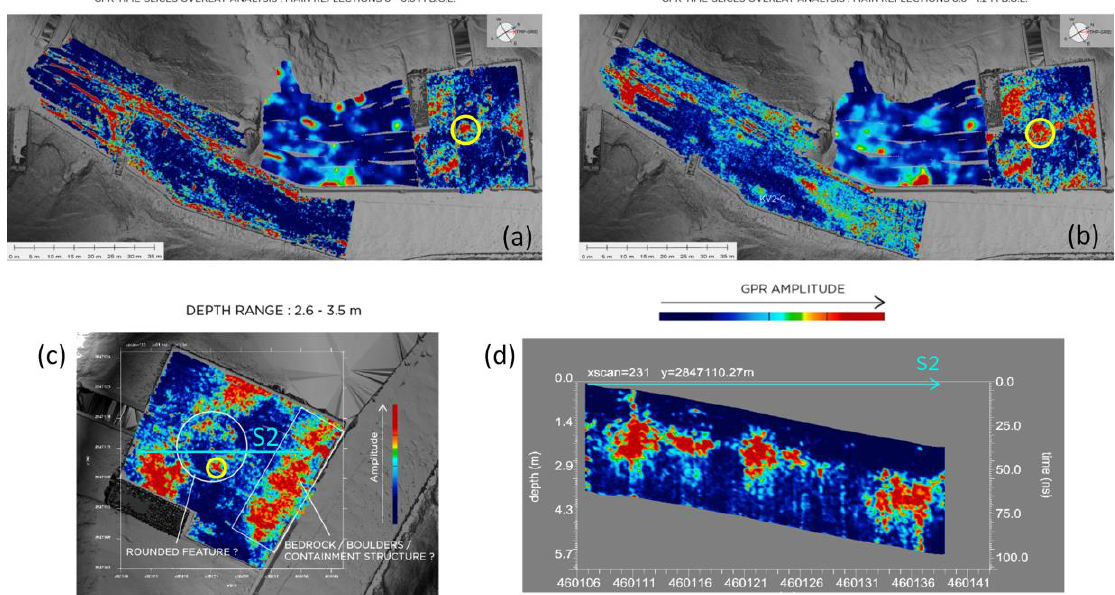
Figure 15. Results of GPR time slice overlay analysis over and around the KV2-A area. In ( a ) and ( b ) a sequence of time slices for two representative depth ranges is reported. In ( c ) and ( d ) a focus on the area in front of KV2 with: a time slice for a representative depth range (c) and the corresponding cross-section S2 (d) showing the distribution at depth of the main anomalies.